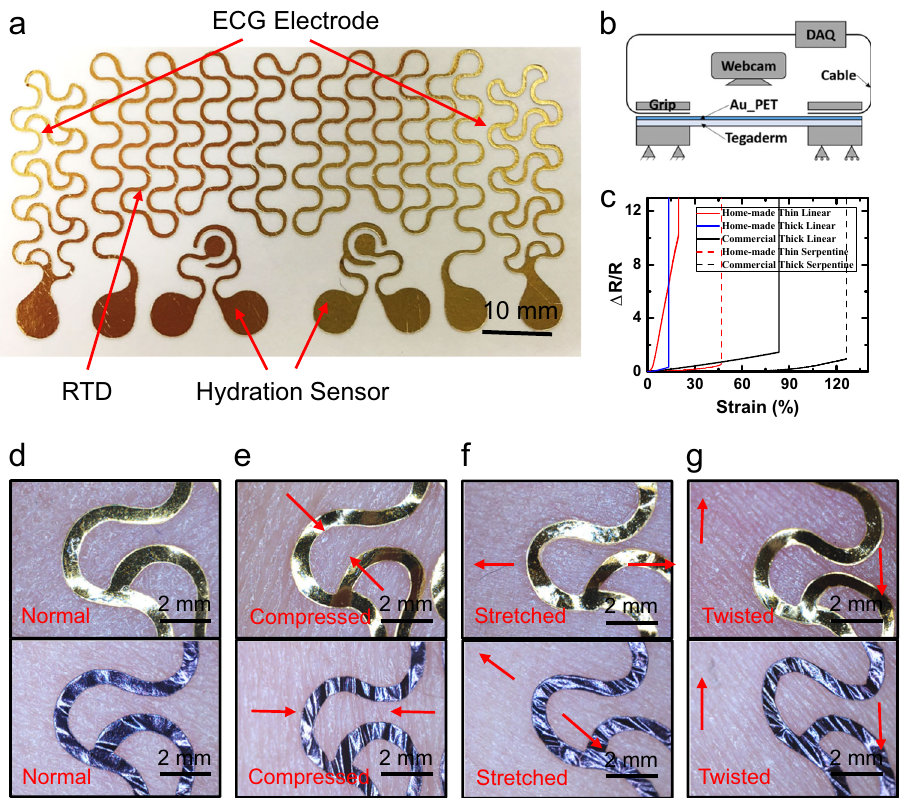
Fig. 2 Mechanical characterizations of e-tattoo. a Top view of an e-tattoo incorporating two ECG electrodes, two hydration sensors, and an RTD, all in fi lamentary serpentine (FS) layout. b Schematics of the tensile testing system with in situ electrical resistance measurement. c Resistance change measured as a function of applied strain. d – g Conformability of open-mesh 13- μ m-thick (upper row) and 1.5- μ m-thick e- tattoo on human change in resistance can rigorously re fl ect the mechanical integrity of the metal ribbon. 38 Figure 2c plots the measured resistance change as a function of the applied tensile strain for several linear (solid curves) and serpentine (dashed curves)